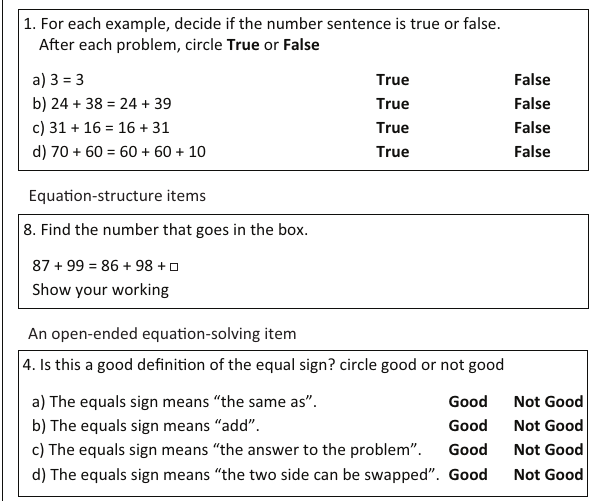
FIGURE 1: Example items from the